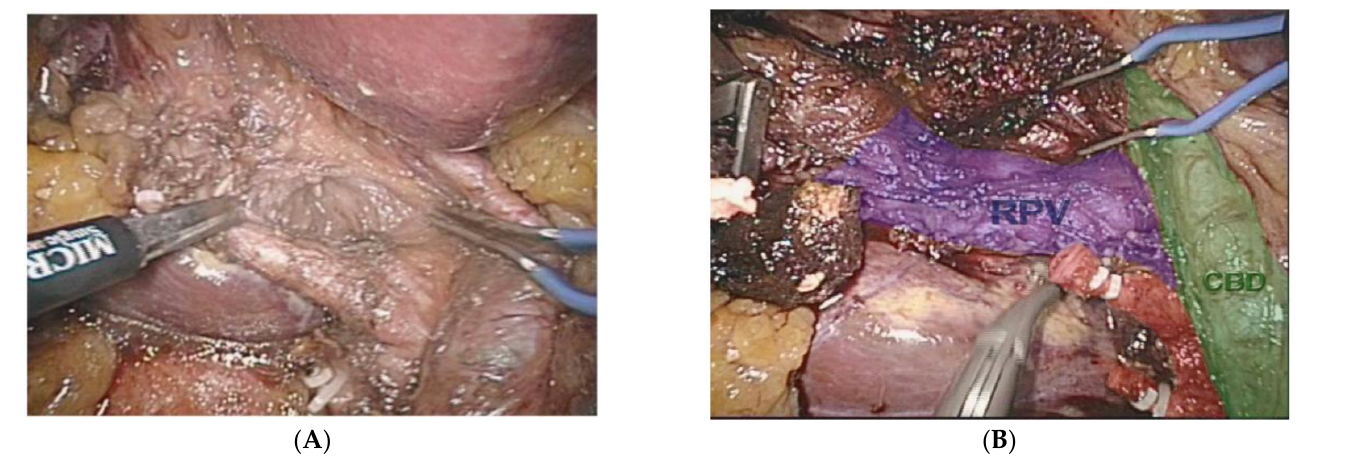
Figure 6. ( A ) Augmented reality (AR) during a minimally invasive extended right liver resection. ( B ) Organ segmentation is possible with the aid of pre-operatively obtained images. Common bile duct (CBD) in green, right portal vein branch (RPV) in blue, clipped and cut anterior and posterior right hepatic arteries in red.